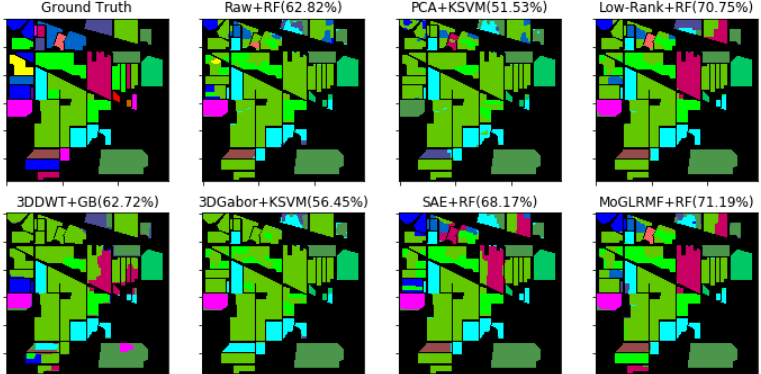
Figure 3. Classification maps of different methods on Indian Pines dataset (1% proportion training samples for each